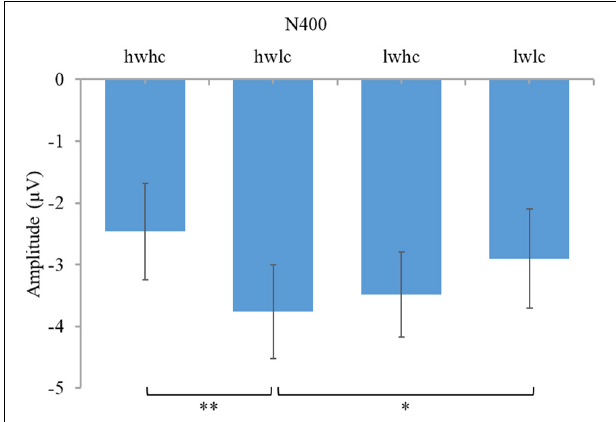
FIGURE 9 | Descriptive statistics and contrasts for the N400 component (hw, high warmth; lw, low warmth; hc, high competence; lc, low competence; ∗ p ≤ 0.05 and ∗∗ p ≤ 0.01).